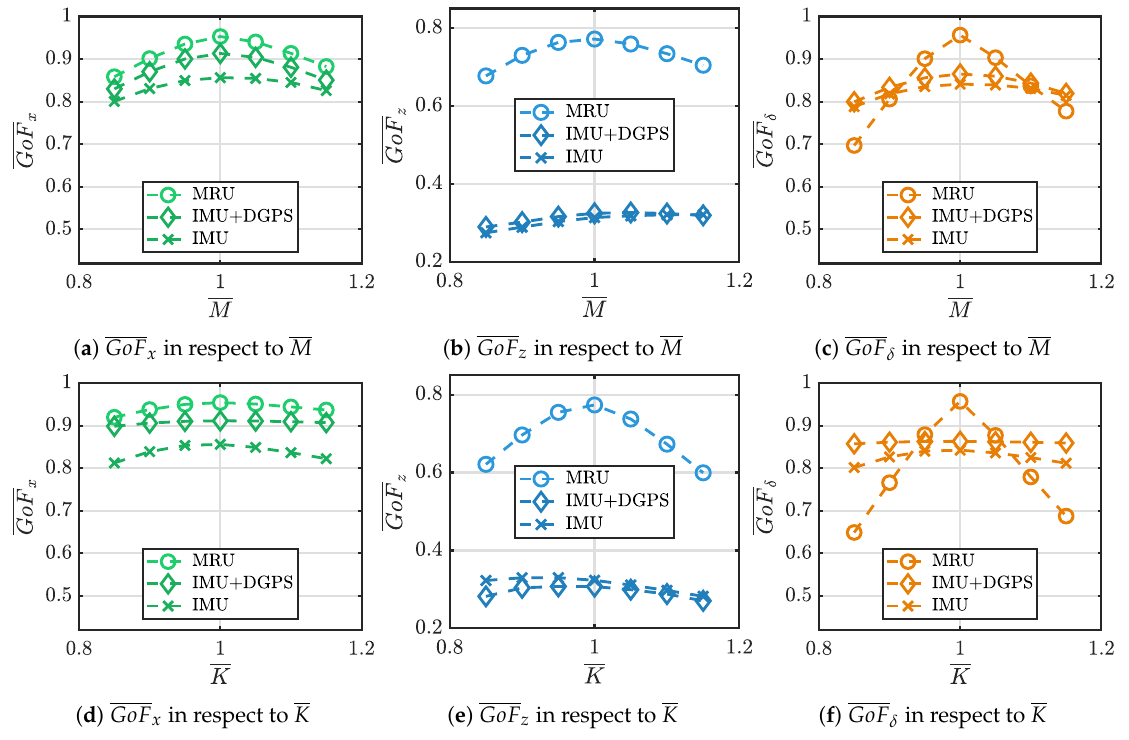
Figure 13. GoF results obtained with the NN varying M and K . The first column refers to the x